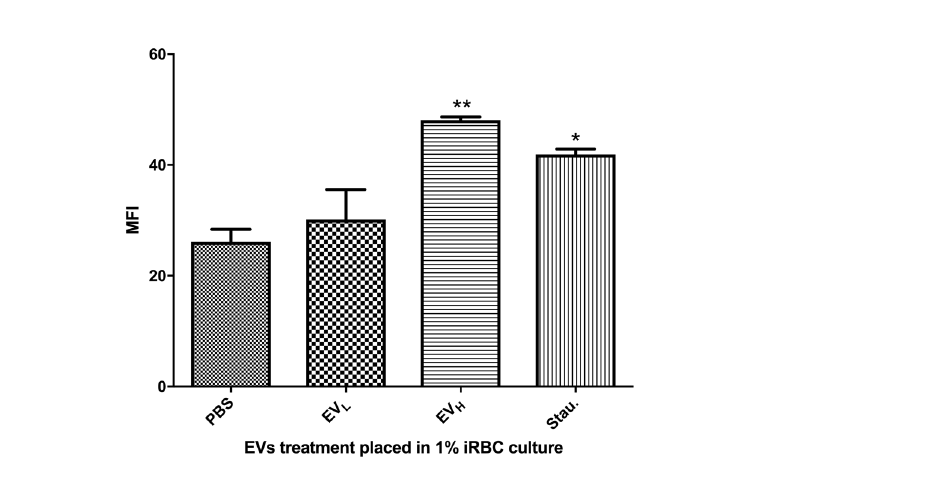
Figure 5. Phosphatidylserine translocation after challenge with EVs.